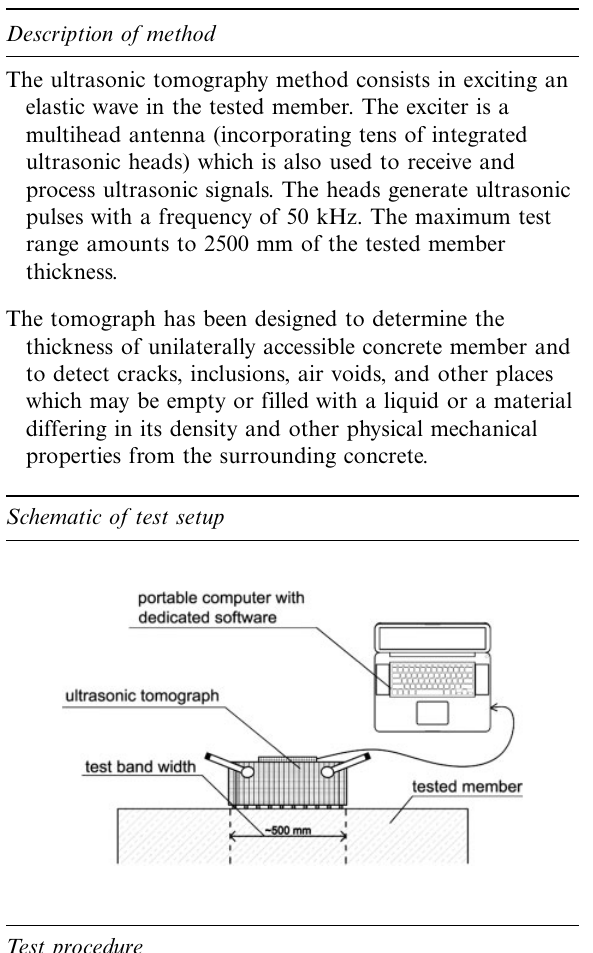
Table 2. Concise description of ultrasonic tomography method (Kozlov et al . 1997; Bishko 2007; Bishko et al . 2008)